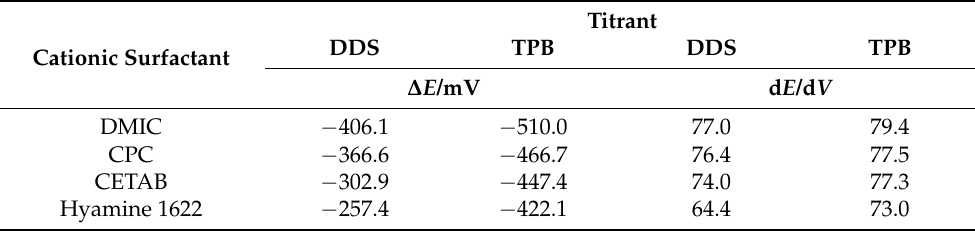
Table 3. Response characteristics for the DODI-TPB surfactant sensor to DMIC, CPC, CTAB, and Hyamine 1622 (mean values ± 95% confidence limits).